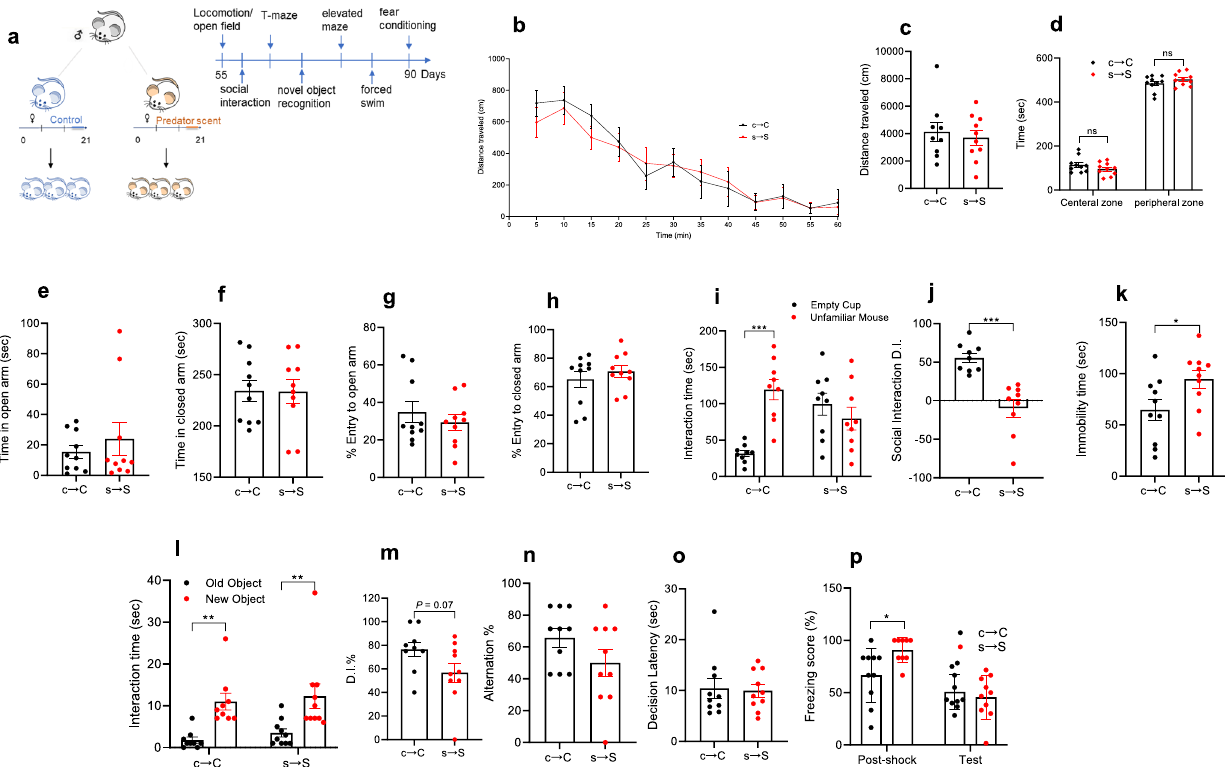
Fig. 1 The s → S pups display depressive-like behavior, social impairment, but normal cognitive functions. a Schematic of the experiment design. b , c s → S pups display normal locomotor activity. b Time-course of the locomotor activity, ( c ) Distance mice travelled in 60 min of the locomotion assay ( n = 10 c → C, 10 s → S). Unpaired student test ( t = 0.2723, P = 0.7885): c → C vs s → S, ns not signi fi cant ( P > 0.05). Data are presented as means ± S.E.M. d Time mice spent in the central and peripheral zones in 10 min in the locomotion assay ( n = 10 c → C, 10 s → S). Two-way ANOVA revealed a signi fi cant zone effect ( F 1,36 = 1453, P < 0.0001) followed by Bonferroni post hoc test: c → C vs s → S, ns not signi fi cant ( P > 0.05). e , f Elevated plus maze measure of time spent in ( f ) Closed (unpaired t -test; t = 0.788, P = 0.44), and ( e ) open arms (unpaired t -test; t = 0.788, P = 0.44). g , h Elevated plus maze measure of percent entry to ( h ) Closed (unpaired t -test; t = 0.05, P = 0.95), and ( g ) open arms (unpaired t -test; t = 0.74, P = 0.46). i Time mice spent